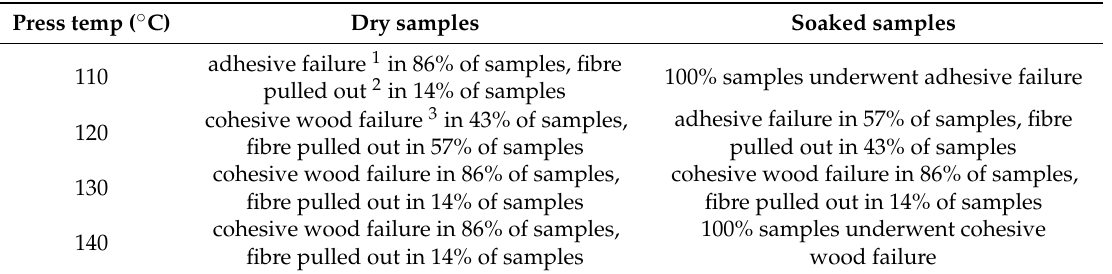
Table 2. Mode of failure of dry and soaked samples hot pressed at different temperatures. For each condition, seven test specimens were examined.